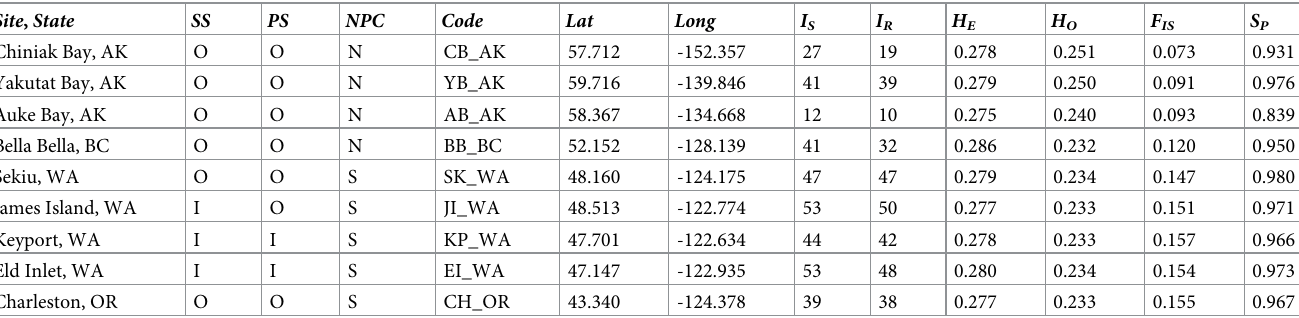
Table 1. General information by collection site.